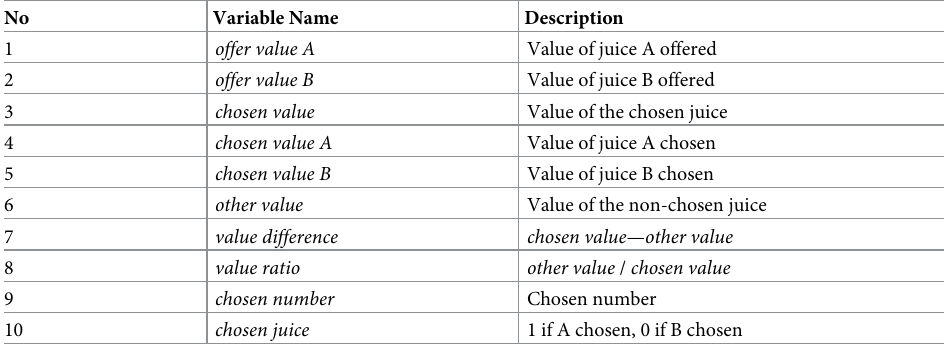
Table 1. Considered list of variables that are potentially encoded by the